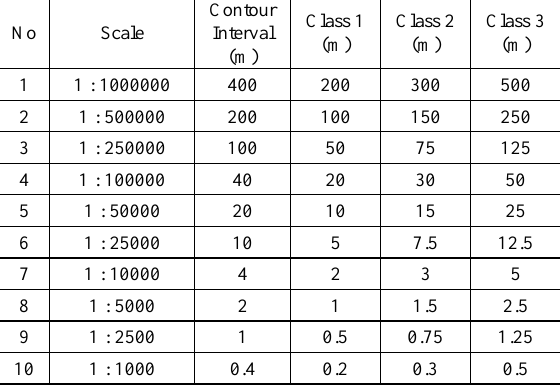
Table 1. Vertical accuracy standard from Geospatial Information Agency of Indonesia to make various